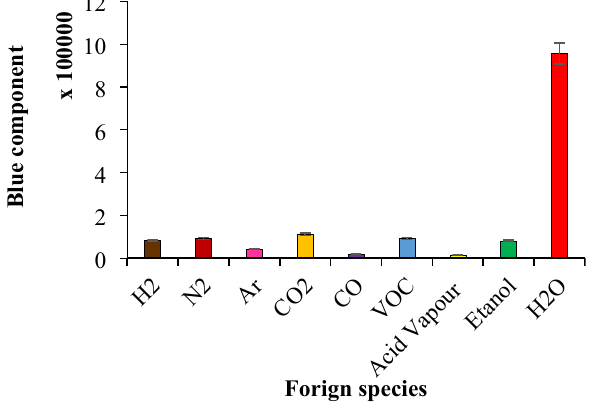
Forign species Figure 11. Selectivity of developed sensor. Conditions: standard RH: 40–45%, applied voltages: 110 ± 1 V (AC, vs. GND), and pressure: 25–30 torr. Tolerance ratio: at least 100-fold excess. The data are the average of three independent analyses at optimum conditions. Error bar: ± relative standard deviation.